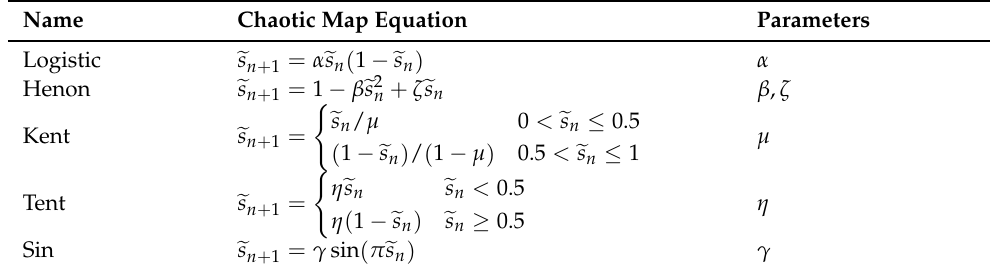
Table 1. Chaotic mapping